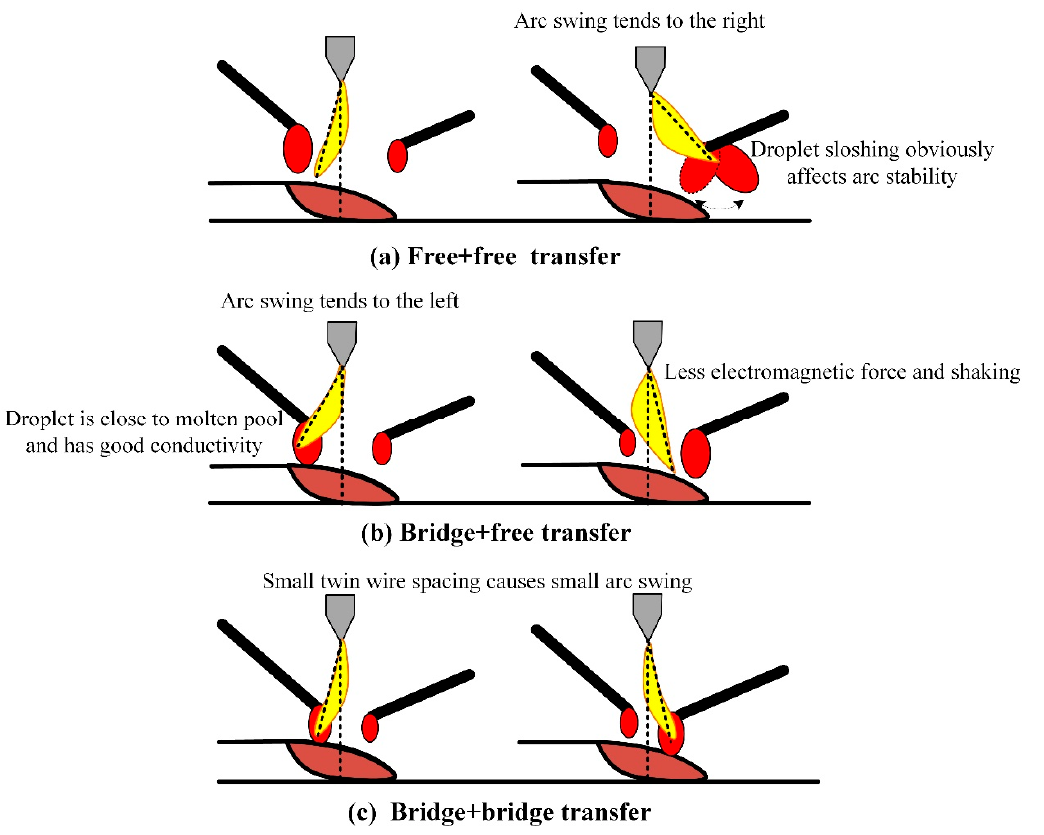
Figure 14. Arc swing in deposition process in three droplet transfer modes. ( a ) free transfer + free transfer ( b ) bridge transfer + free transfer ( c ) bridge transfer + bridge transfer.